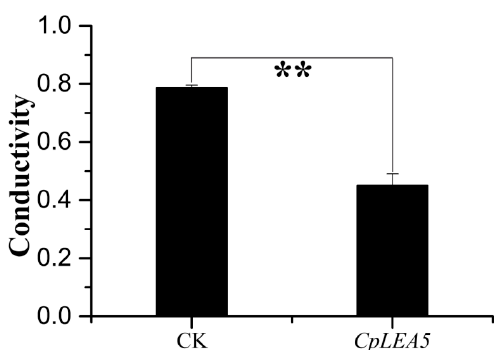
Figure 4. Difference in cell membrane permeability after low temperature treatment at − 20 °C for 60 min. Data are means ± standard deviations of three replications. ** Significant difference at p < 0.01.